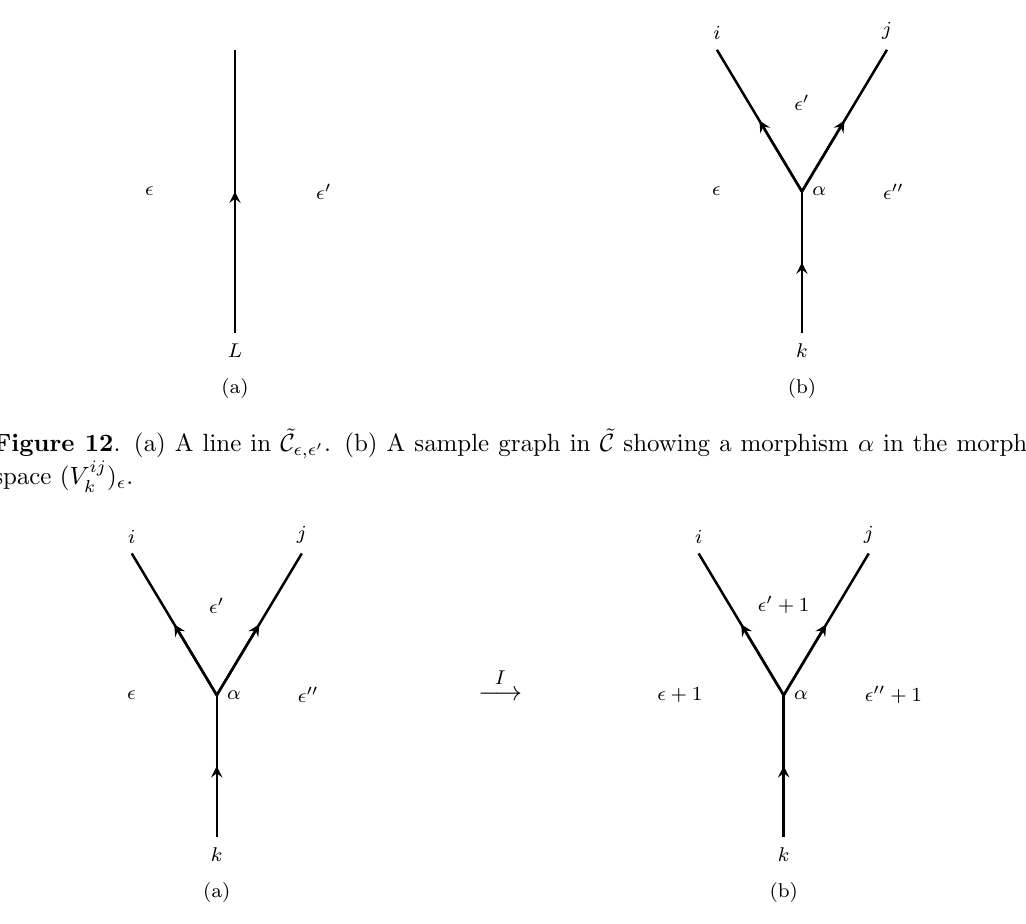
Figure 13 . The action of anti-linear isomorphism I